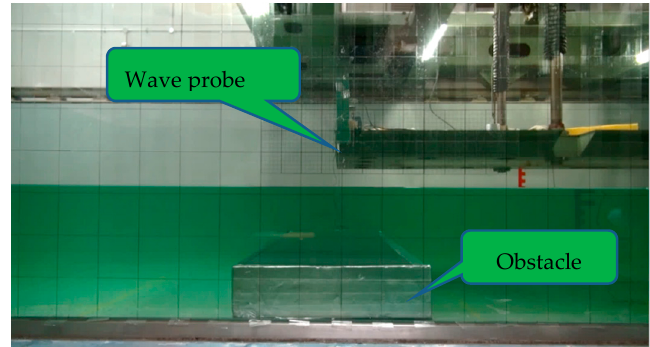
Figure 6. Experimental setup with a box-shape obstacle.